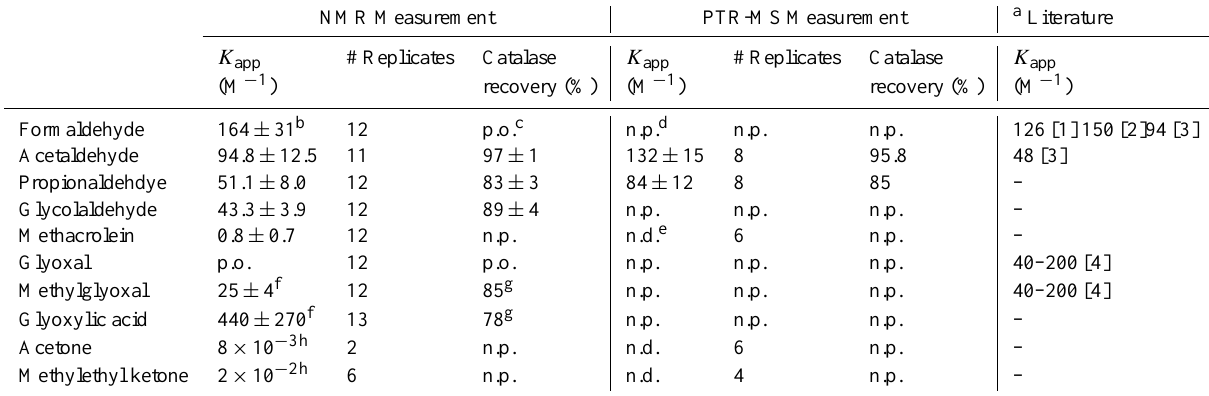
Table 2. Summary of the apparent equilibrium constants of α -HHP formation ( K app ) measured and reported in literature at 25 ◦ C. The constants are reported with their standard deviation acquired from the number of replicates shown on the